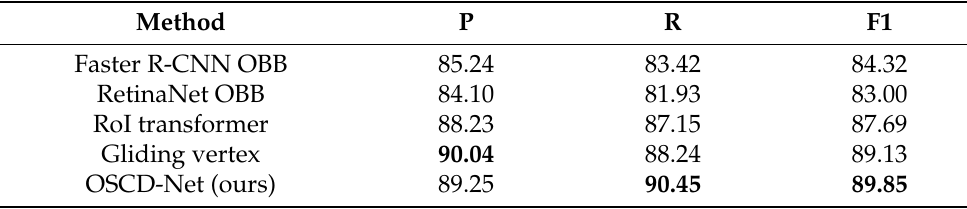
Table 8. Performance evaluation with Precision(P), Recall(R) and F1 on the SSDD+ dataset. The highest value is indicated by bold numbers